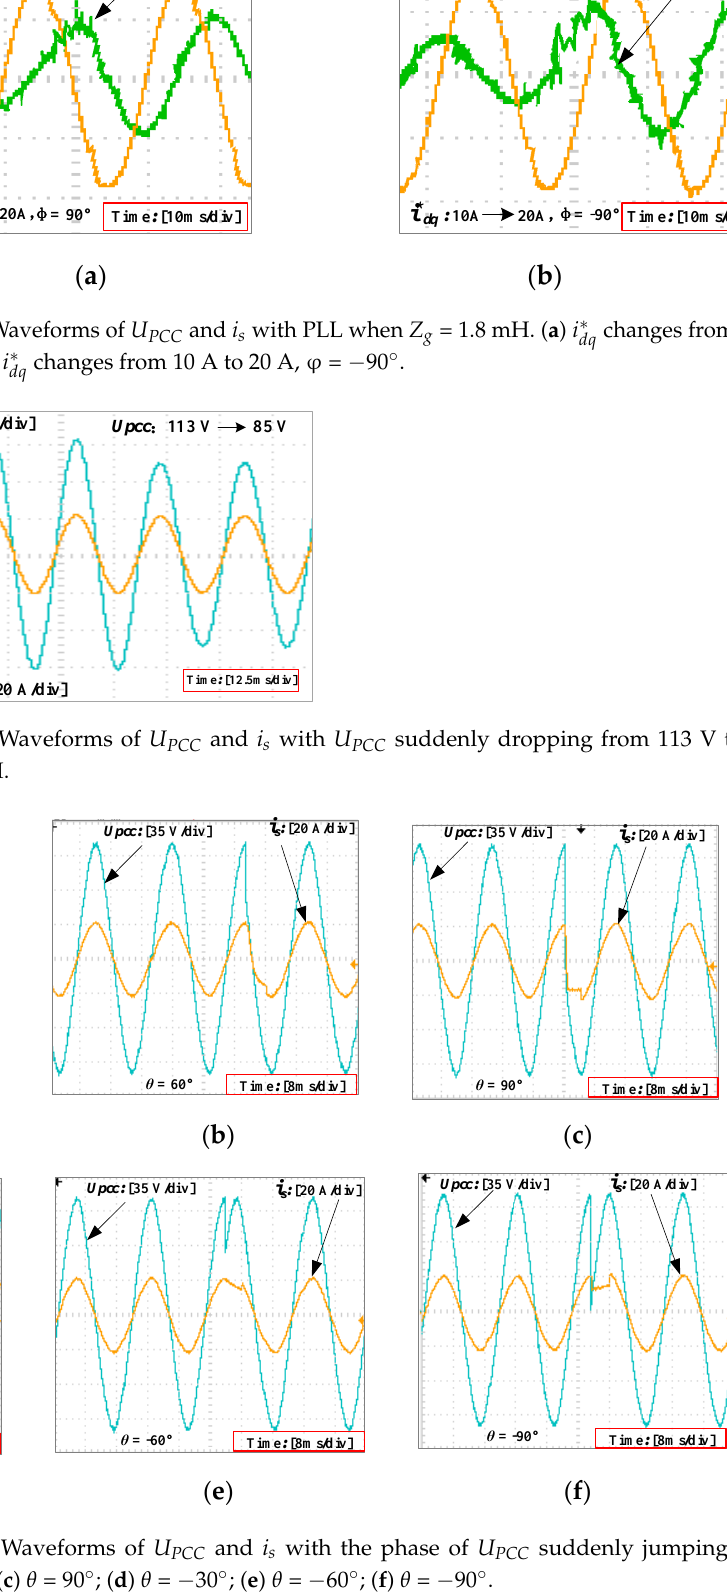
Figure 18. Waveforms of U PCC and i s with the phase of U PCC suddenly jumping. ( a ) θ = 30° ; ( b ) θ = 60°; ( c ) θ = 90°; ( d ) θ = −30° ; ( e ) θ = −60°; ( f ) θ = −90°.